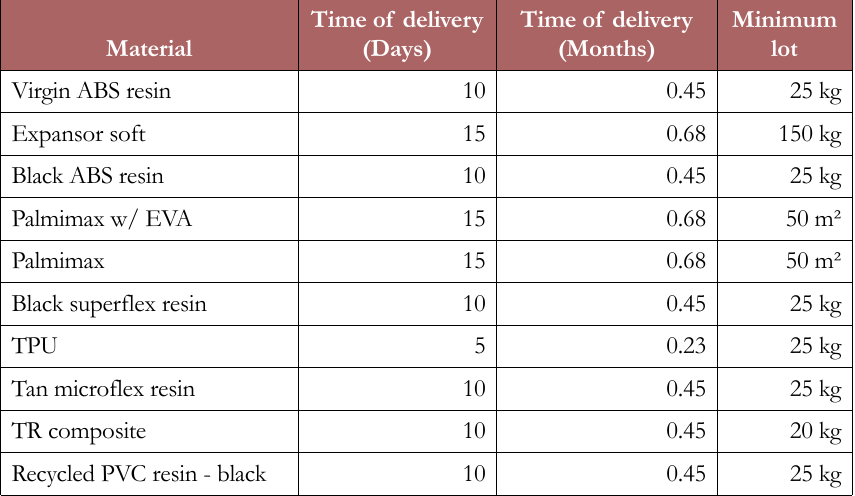
Table 4. Time of delivery and minimum order quantity